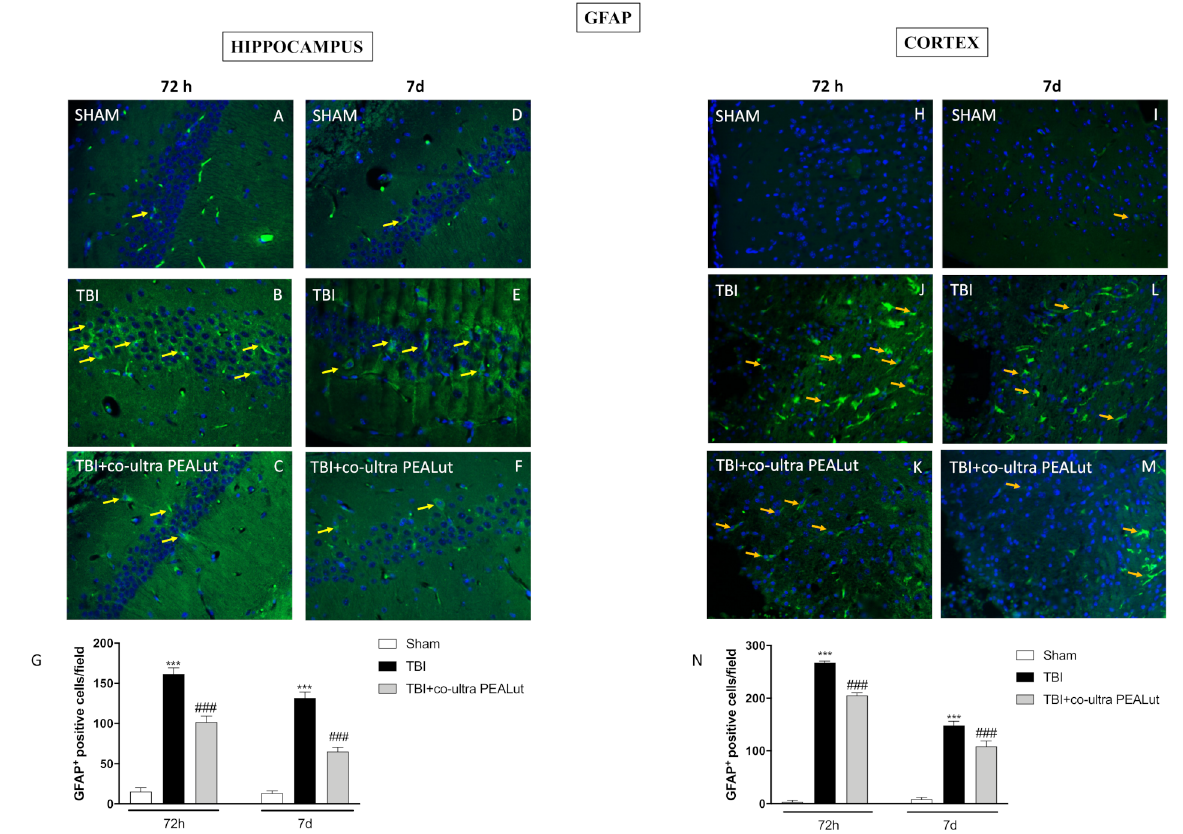
Figure 5. Effect of co-ultra PEALut on astroglial cell activation. GFAP + cells significantly increased at 72 h and 7 d post-TBI in both hippocampus ( B , E , G ) and cortex ( J , L , N ); while co-ultra PEALut treatment decreased GFAP+ cells in the hippocampus ( C , F , G ) and cortex ( K , M , N ). Sham did not show any astrogliosis ( A , D , G and H , I , N ). Magnification 40 × . Yellow arrows indicate the positive staining for GFAP. Data are expressed as Mean ± SEM from N = 10 mice for each group. One-way ANOVA test. *** p < 0.001 vs. corresponding Sham group; ### p < 0.001 vs. corresponding